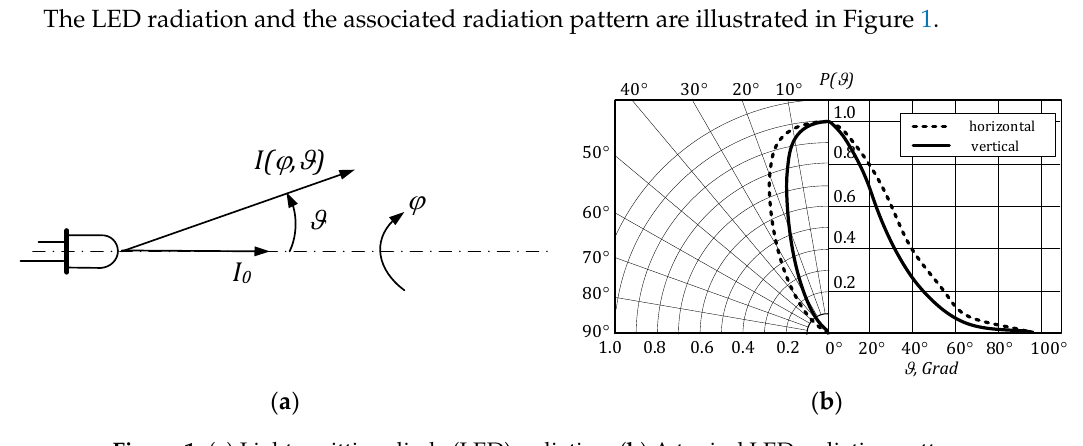
Figure 1. ( a ) Light-emitting diode (LED) radiation; ( b ) A typical LED radiation pattern.